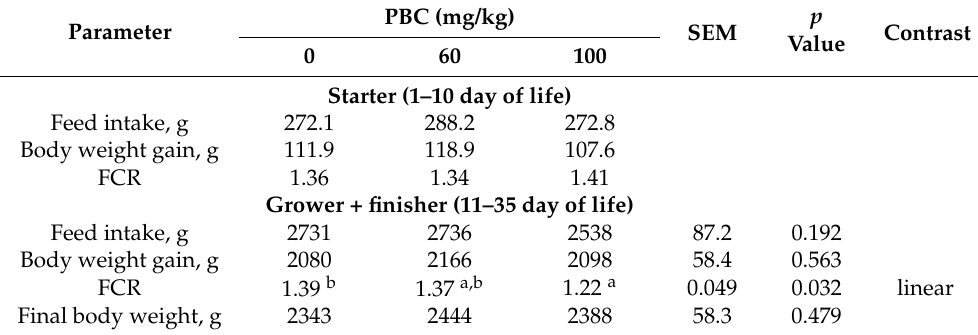
Table 2. Growth performance parameters in chickens fed diets supplemented with 60 and 100 mg/kg